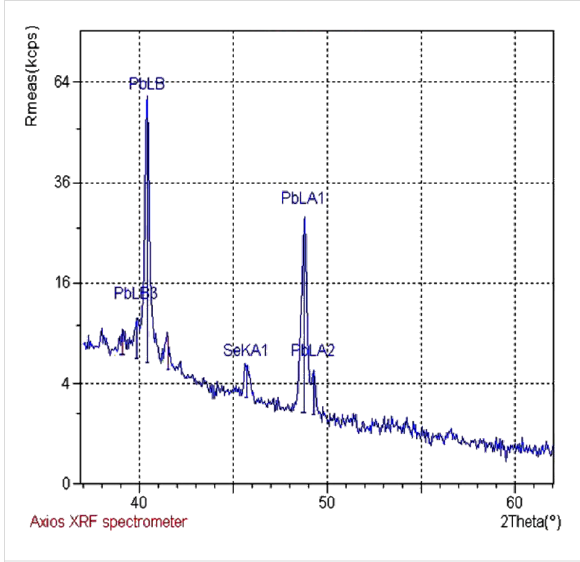
Figure 6: XRF spectra of PbSe prepared at 333 K.